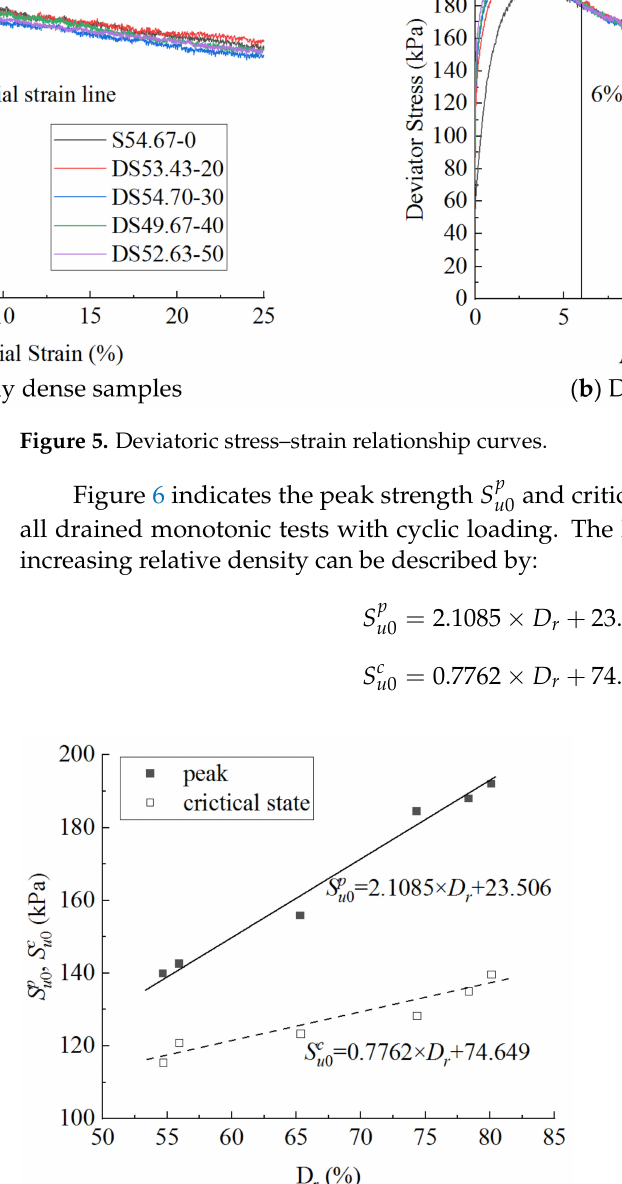
Figure 6. The relationship between peak/critical state strength and relative